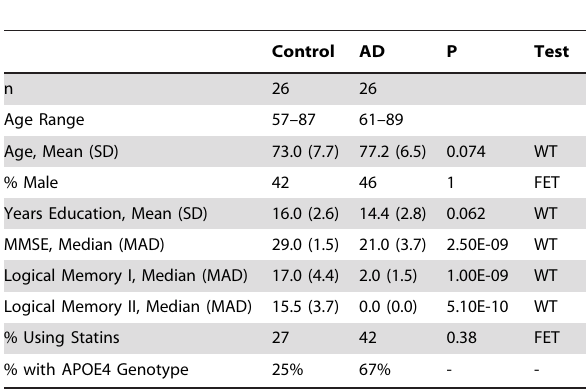
Table 1. Clinical and demographic characteristics of Alzheimer’s subjects and controls a